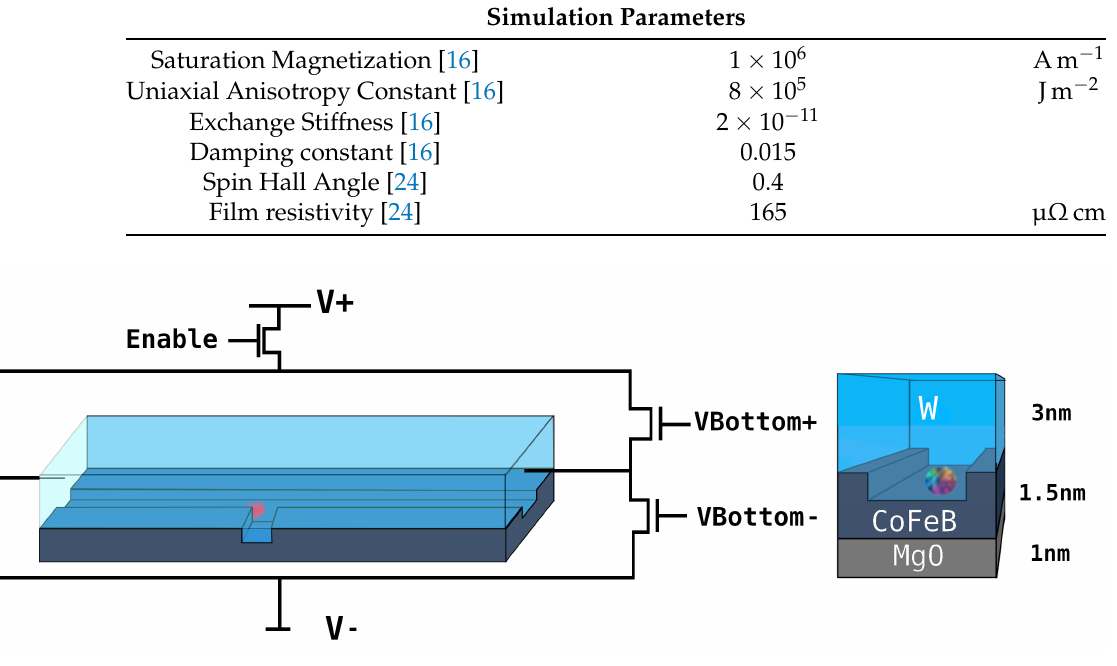
Figure 2. Basic memory racetrack structure and stack composition. The track is connected to V+ and V − in order to move the skyrmion in both